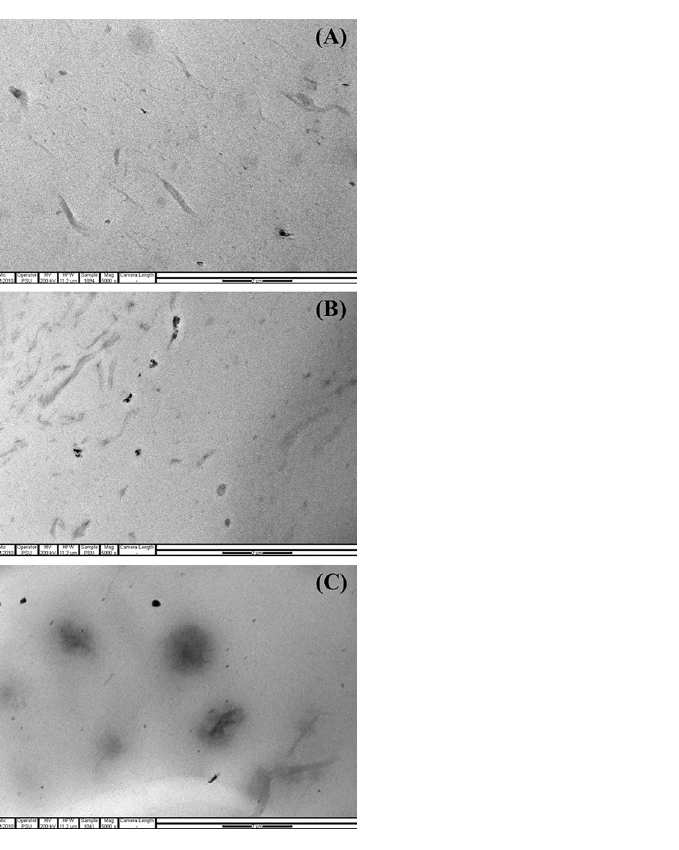
Figure 2. TEM images of ( A ) CNF1/NR, ( B ) CNF3/NR, and ( C ) CNF5/NR at low